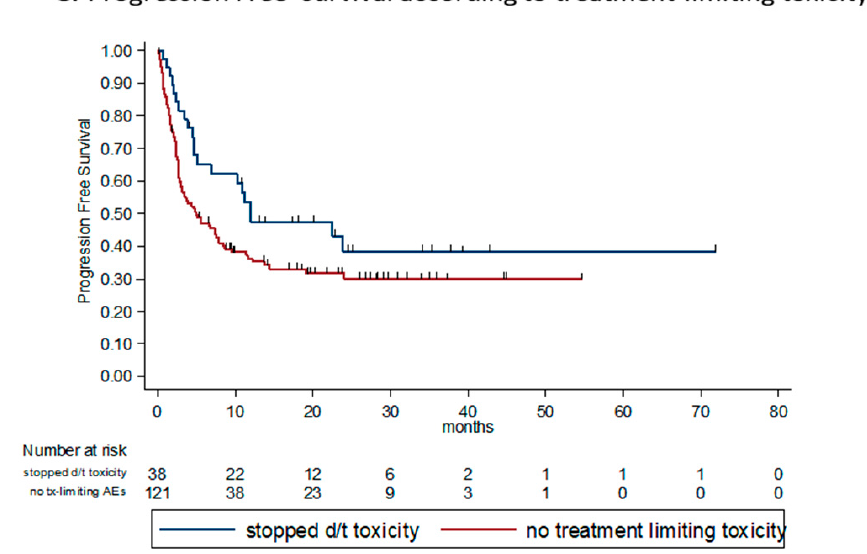
Figure 4. Kaplan-Meier survival estimates according to maximal grade of adverse event and according to treatment discontinuation. ( A ) OS according to maximum grade of AE. HR for death was 1.09 (95% CI 0.62–1.95, p = 0.746) for patients experiencing grade 3–4 AEs compared to those who experienced grade 1–2